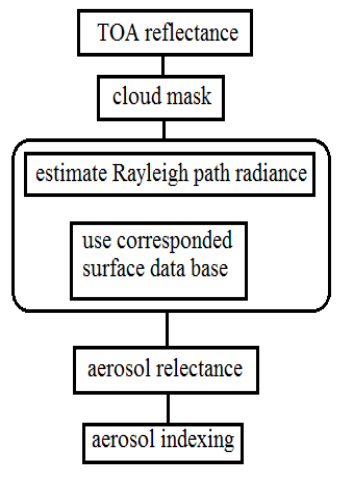
Figure 1. Schematic algorithm steps